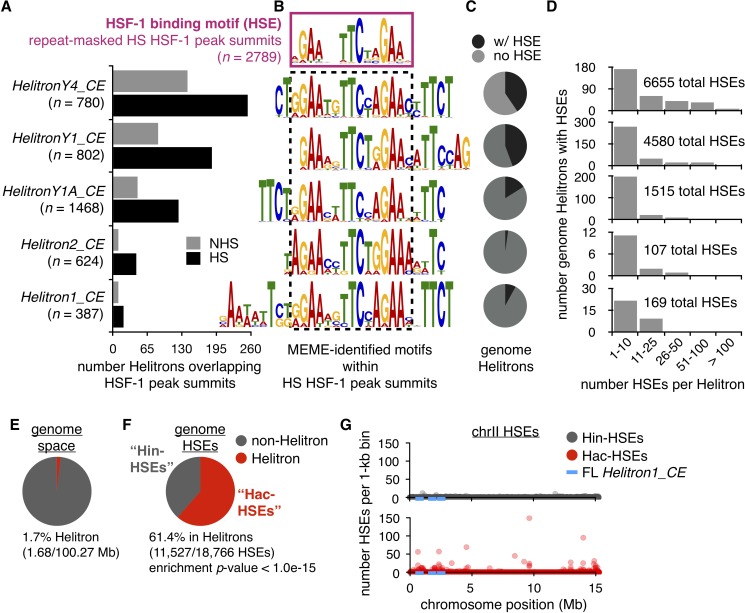
Helitrons contribute a significant number of HSEs to the C. elegans genome.(A) Number of Helitrons that overlap with 101 bp regions centered around HSF-1 peak summits (ChIP-seq data from Li et al. (2016); peaks called using MACS2, Zhang et al., 2008) in non-heat shock (NHS) and heat shock (HS) conditions. Helitron coordinates were obtained from the RepeatMasker track downloaded from the UCSC Genome Browser (genome assembly ce11, Kent et al., 2002). (B) De novo motifs extracted from 101 bp regions centered around HS HSF-1 peak summits using MEME (Bailey and Elkan, 1994). The HSE motif extracted from all repeat-masked HS HSF-1 peak summits is boxed with a solid purple line, while HSE-like motifs found within non-repeat-masked summits that overlap with Helitrons are boxed with a dashed black line. For repeat-masked HSF-1 peak summits, the displayed HSE motif is the most significant motif found. For Helitron-overlapping summits, displayed HSE-like motifs are within the top 10 significant motifs identified and are significantly similar to the HSE motif extracted from repeat-masked summits using the Tomtom motif comparison tool (q-value <1.0e-03) (Gupta et al., 2007). (C) Pie chart displaying the proportions of all genomic Helitrons in which HSEs are present (black) or absent (gray). HSEs were identified by scanning the genome with FIMO (q-value <0.05) (Grant et al., 2011) using MEME-derived output from repeat-masked HSF-1 peak summits. (D) Histograms displaying binned numbers of HSEs within all HSE-containing Helitrons found in the genome. Total numbers of HSEs that reside within each Helitron type are also shown. (E) Pie chart displaying the proportion of the C. elegans genome that is annotated as Helitron (red) or not (gray). (F) Pie chart displaying the number of HSEs in the C. elegans genome that reside within (red, hereafter referred to as Hac-HSEs) or outside of (gray, hereafter referred to as Hin-HSEs) annotated Helitrons. HSEs are significantly enriched within Helitron sequences (p<1.0e-15, binomial test). (G) Numbers of Hin- (gray) and Hac-HSEs (red) within 1 kb bins along the length of chromosome II (chrII). The approximate positions of full-length (FL) Helitron1_CE elements are shown using blue lines.